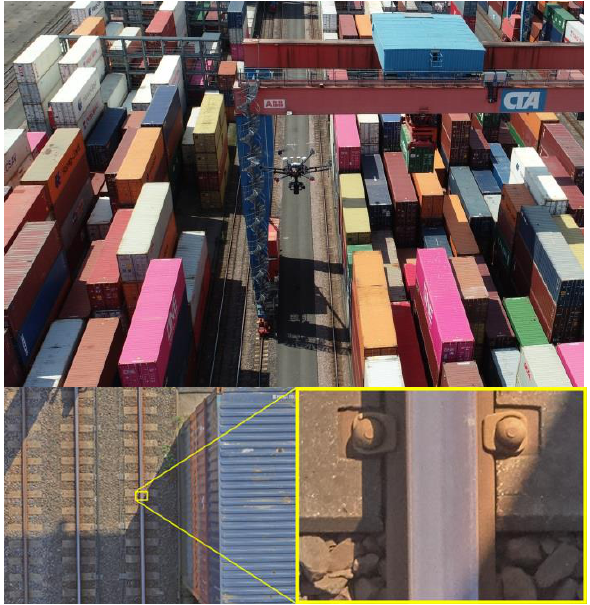
Fig. 6: The study area targeted by the drone (Top), Full coverage of an aerial photo from 35m height (11664x8750) (Down left), and image section (507x380 pixels, corresponds to approx. 45x34cm) (down